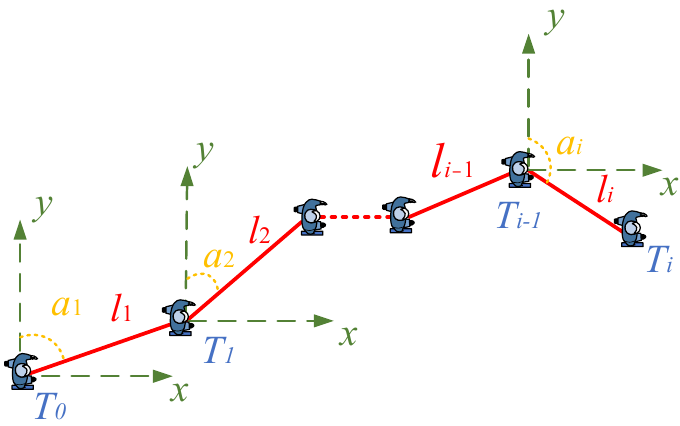
Figure 7. PDR motion model